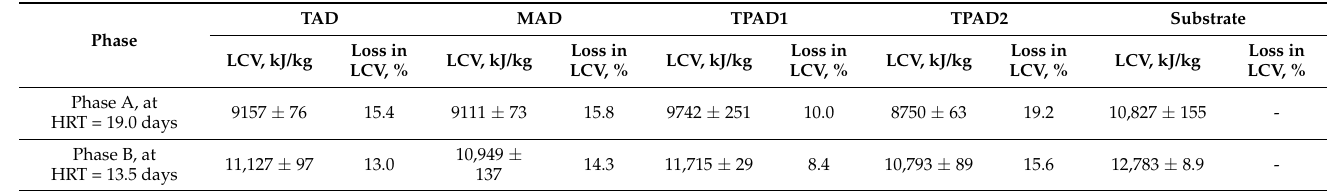
Table 9. Lower calorific value of the digested sludges and